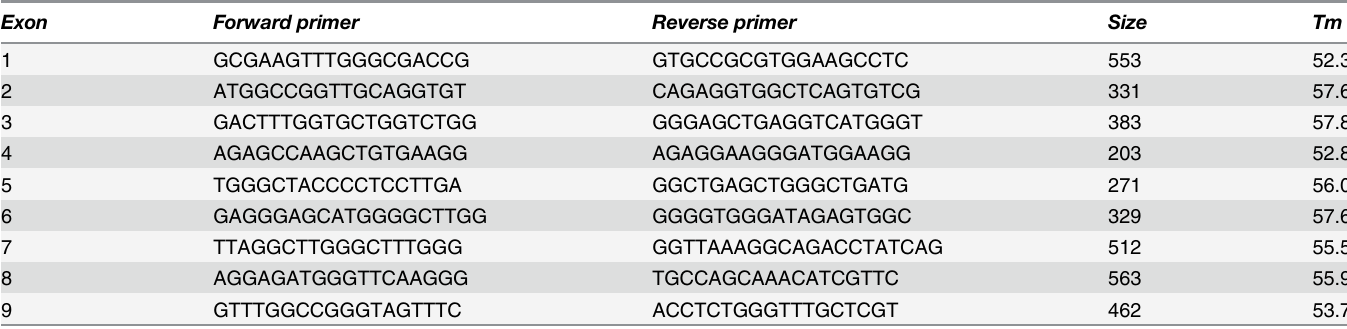
Table 4. PCR primers used for SMAD3 gene sequence